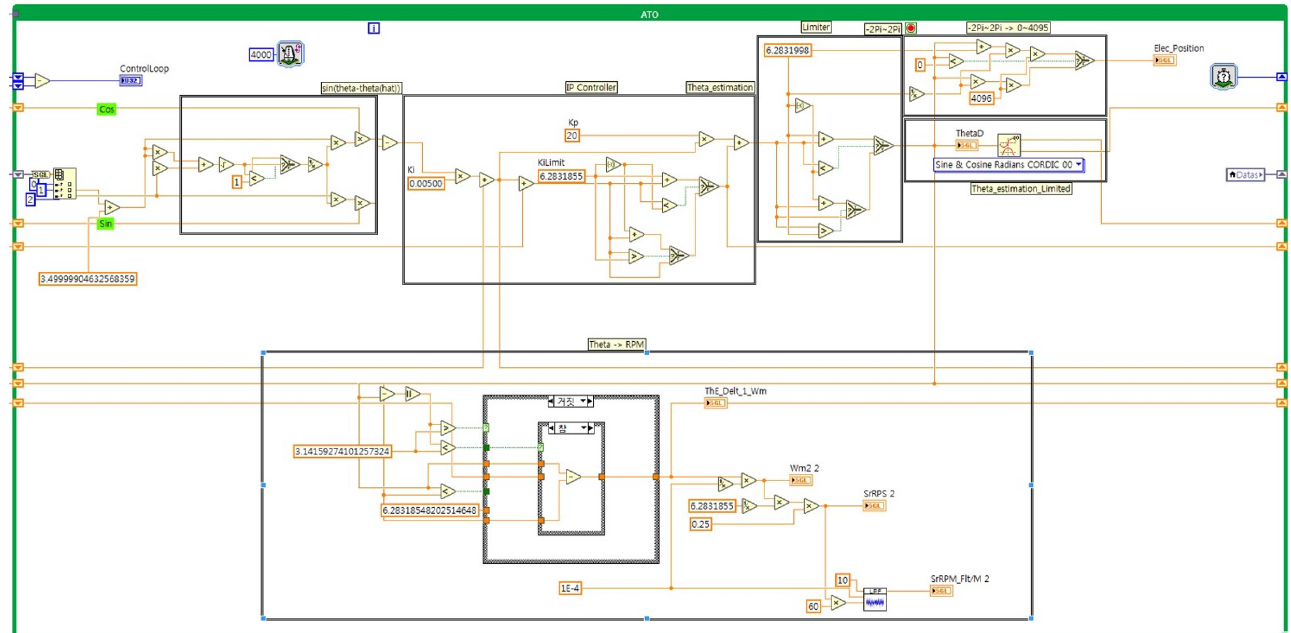
Figure 8. ATO and Resolver offset measure